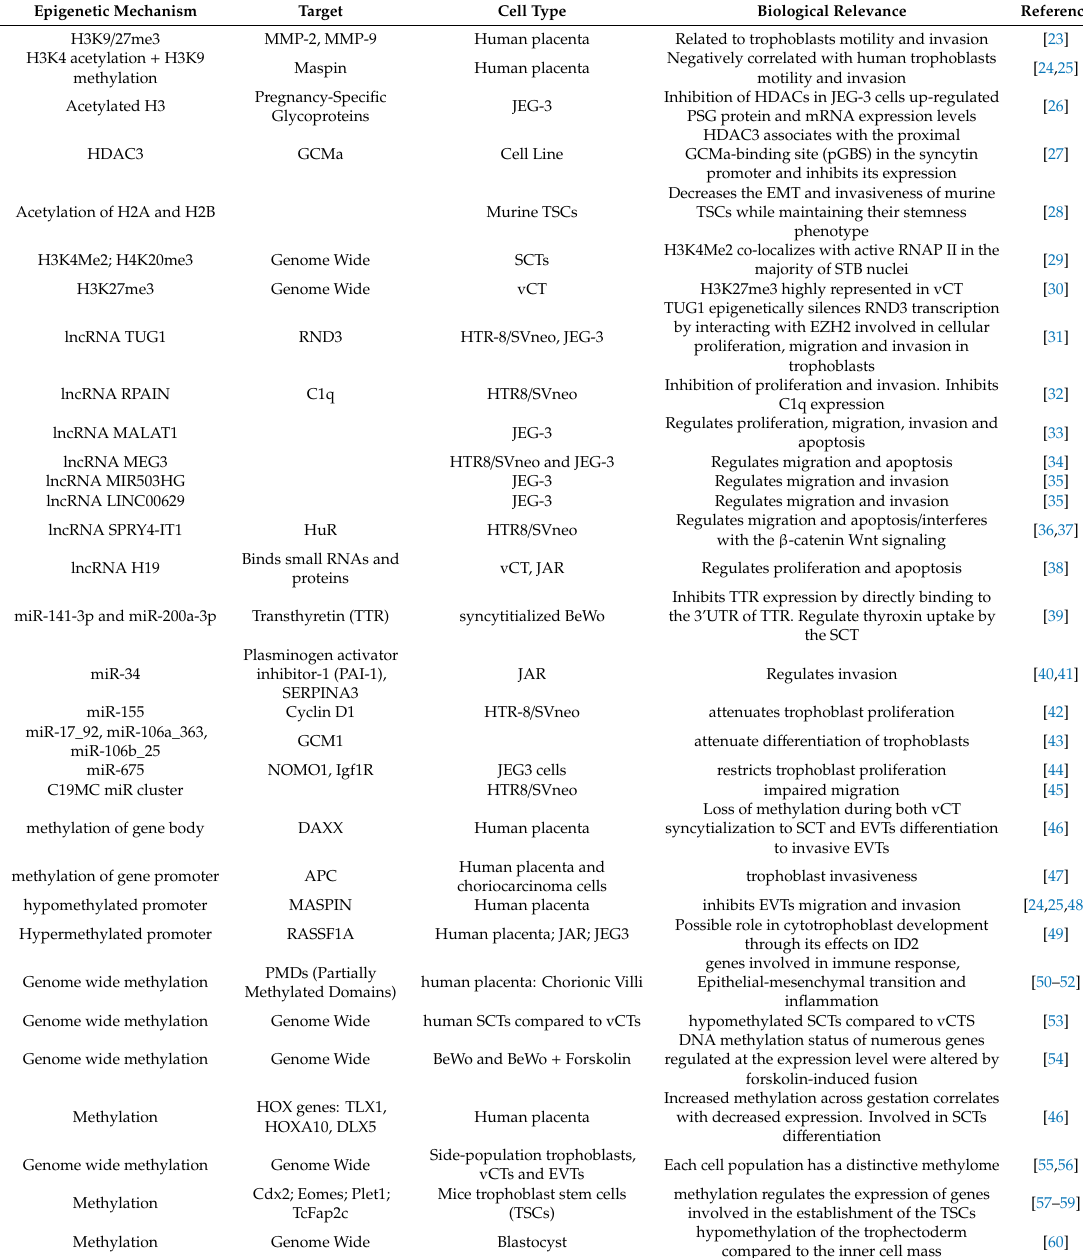
Table 1. Epigenetic mechanisms in placental